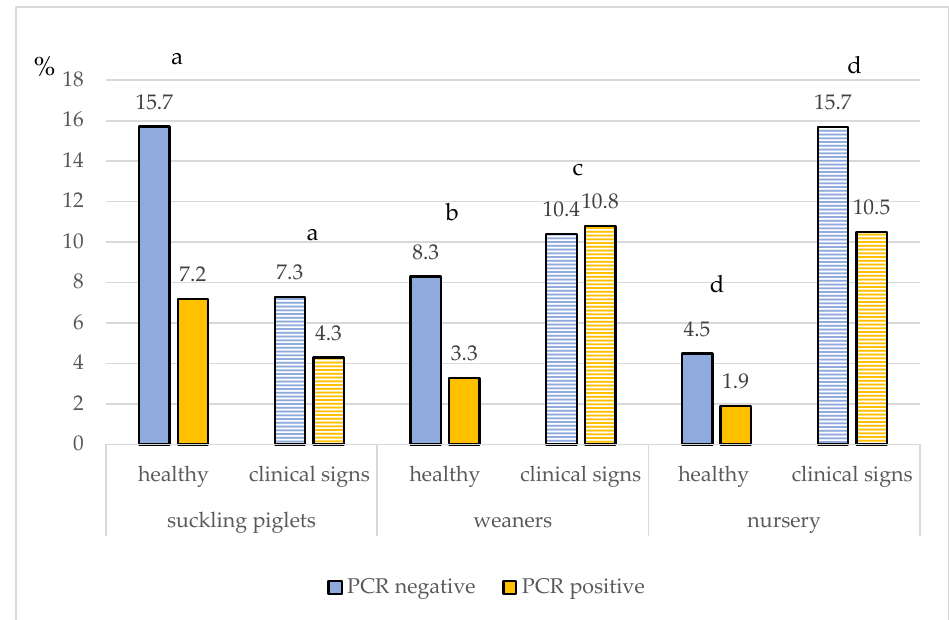
Figure 3. The percentage of positive and negative pools in influenza A ‐ PCR among suckling piglets, weaners, and nurseries with and without clinical signs. Different superscripts within each age group indicate a significant difference ( p < 0.05) between samples with “healthy” animals and animals with “clinical signs”.